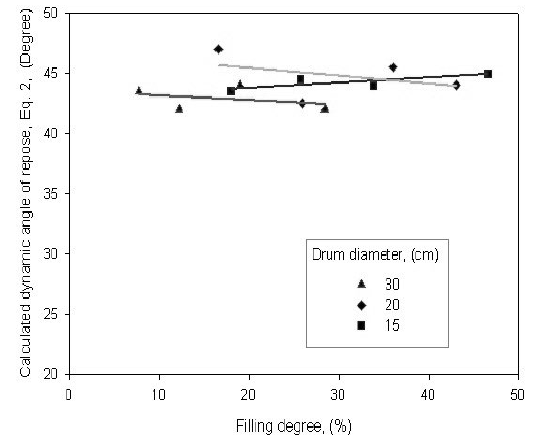
Fig. 8: Effects of filling degree on friction coefficient of rice grains for cylinders with diameters equal to 15, 20, and 30 cm. Tab. 3: Friction coefficient of rice grains using two different methods.